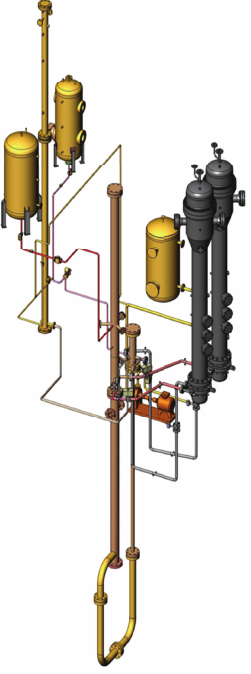
Figure 4: PWR PACTEL